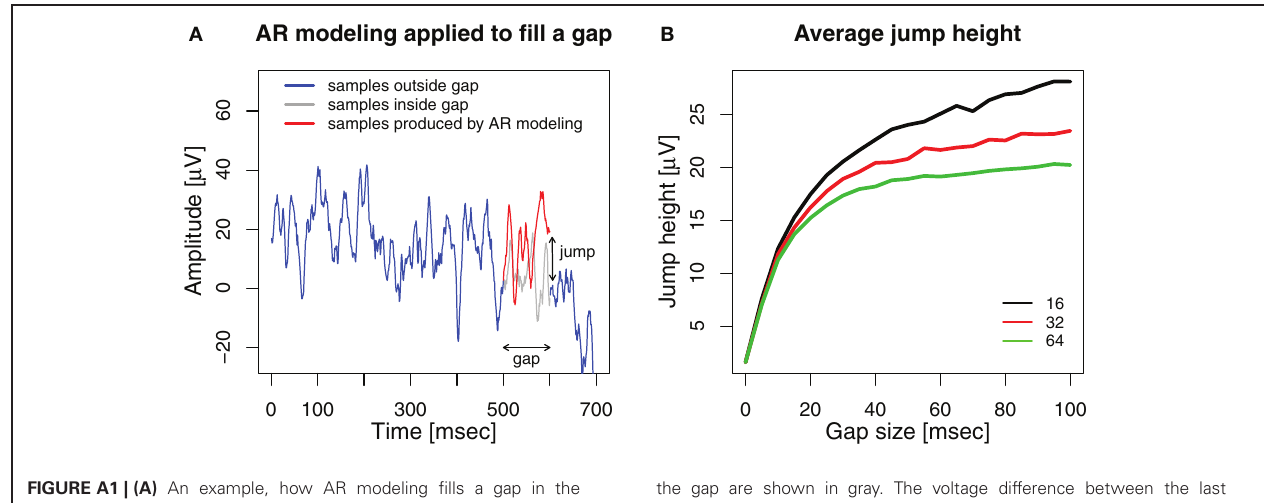
FIGURE A1 | (A) An example, how AR modeling fills a gap in the signal. A gap is introduced into an ECoG signal (blue) between 500 and 600ms. An AR model of order 32 is estimated from the 500ms before the gap and applied as a linear predictor to generate 100 samples to fill the gap (red). The original ECoG samples within